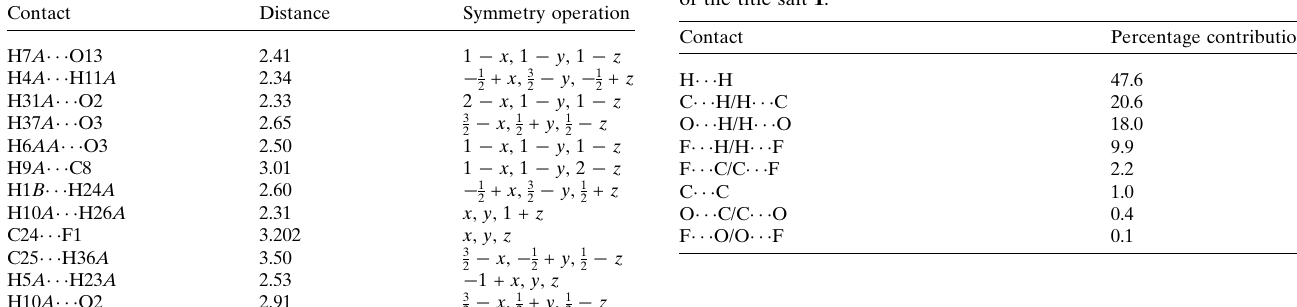
Table 3 Percentage contributions of interatomic contacts to the Hirshfeld surface of the title salt 1 .